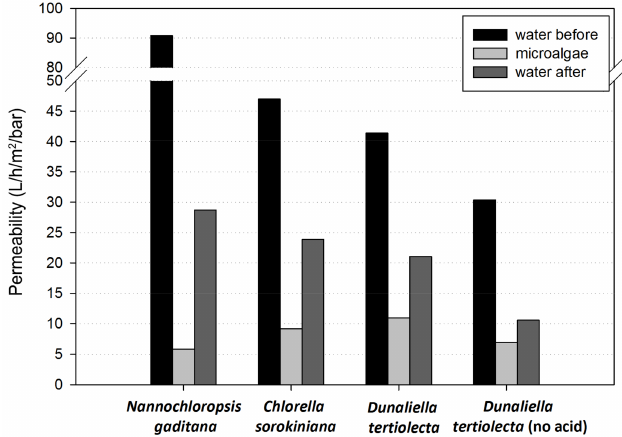
Figure 3. Water and sample permeabilities for the different microalgae